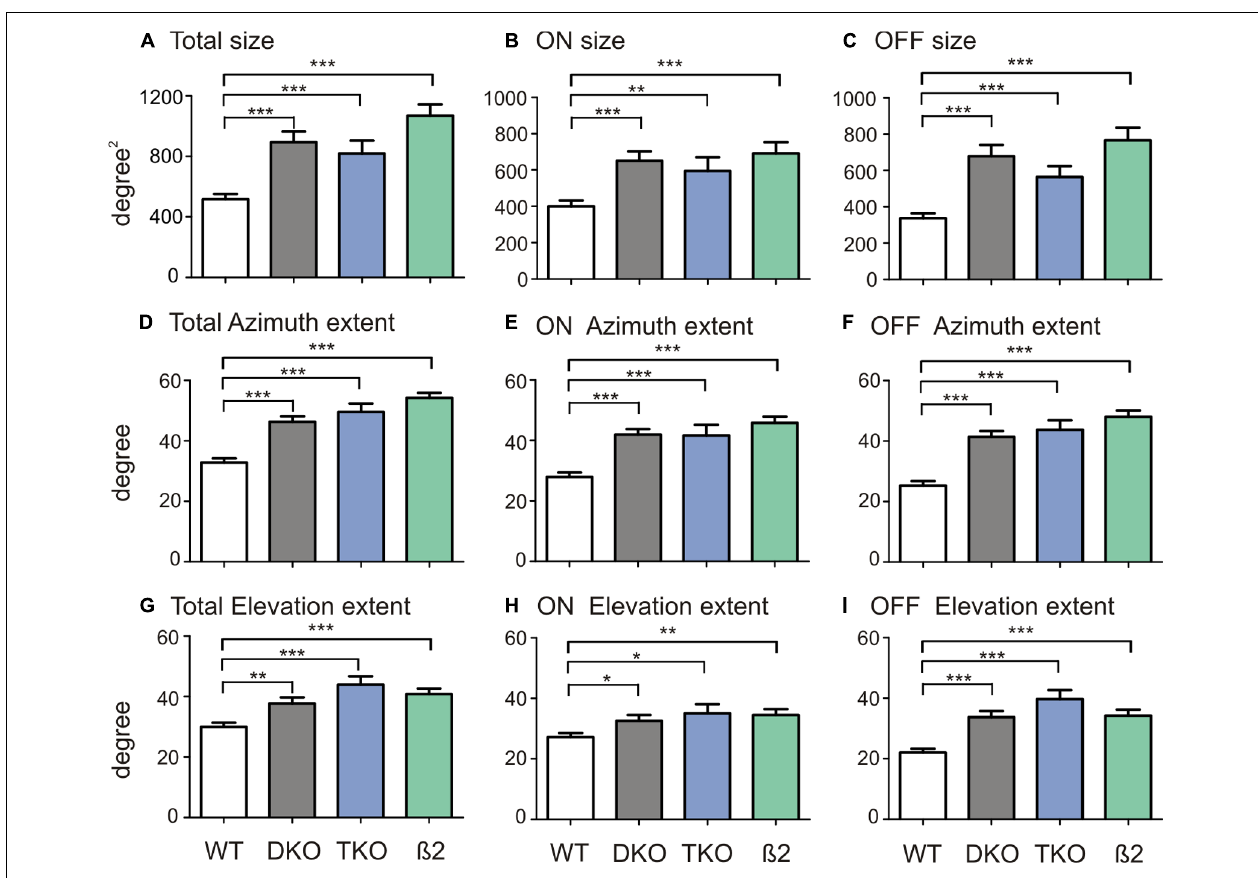
extent along the azimuth axis (D) and that of the On (E) and Off subregions (F) between groups. (G–I) Comparison of receptive field extent along the elevation axis (G) and that of the On (H) and Off (I) between groups. All error bars represent SEM, and * p < 0.05, ** p < 0.01, and *** p < 0.001.